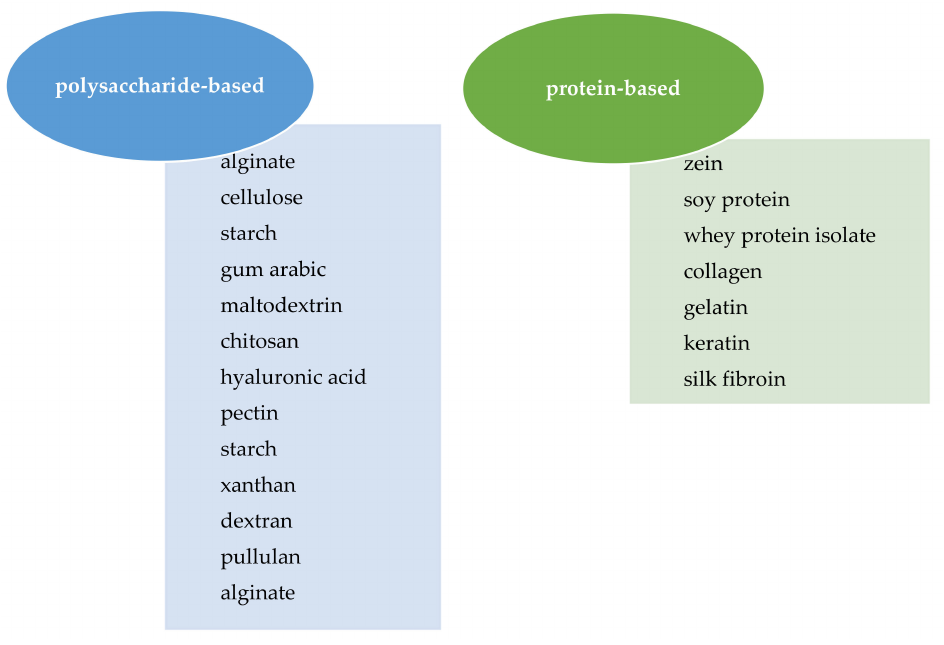
Figure 2. Examples of biopolymers used for microencapsulation